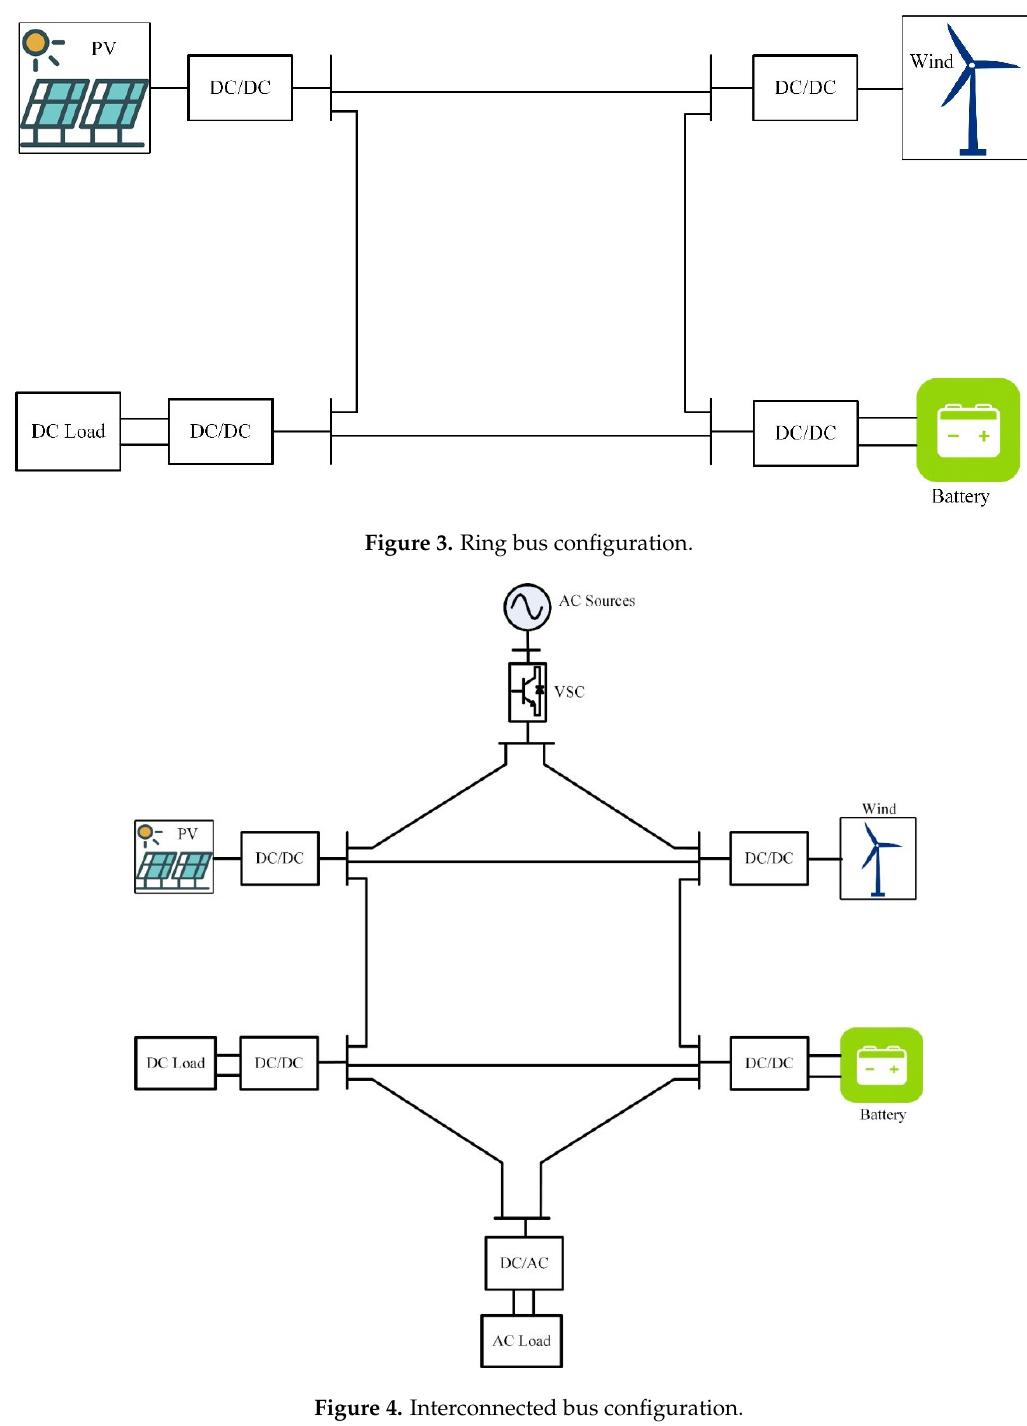
Figure 4. Interconnected bus configuration.